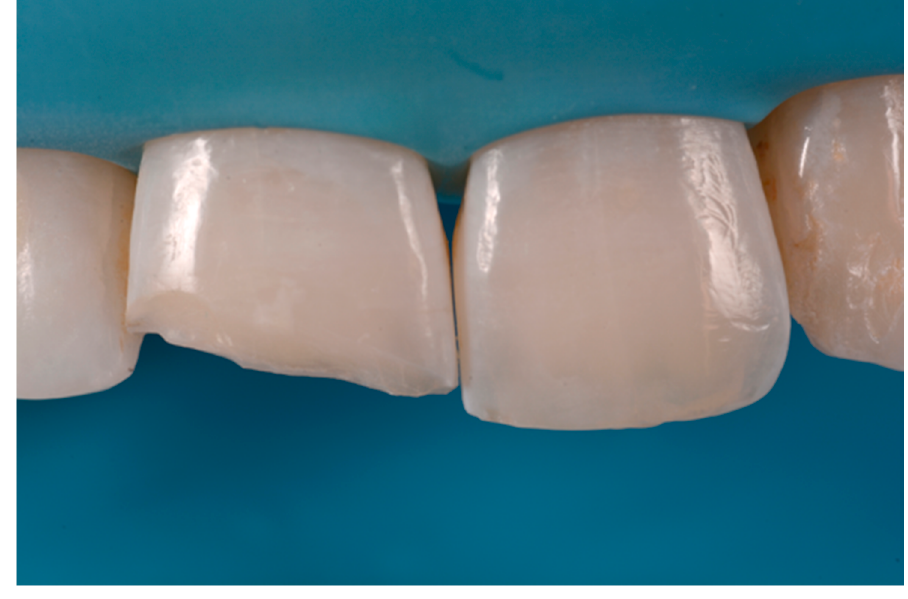
Figure 49. Margin preparation.